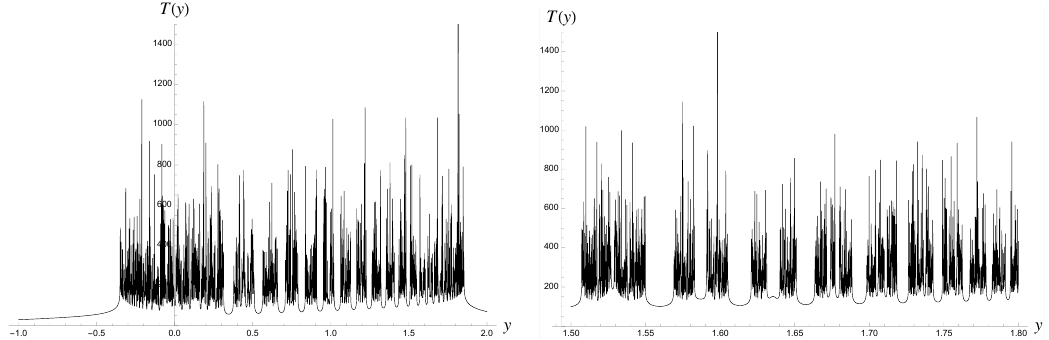
Figure 4 . The escape time T with the initial condition x = 0 , p y = − 0 . 03 and E = 0 . 001 . The right figure zooms in on the area of 1 . 5 < y < 1 . 8 in the left